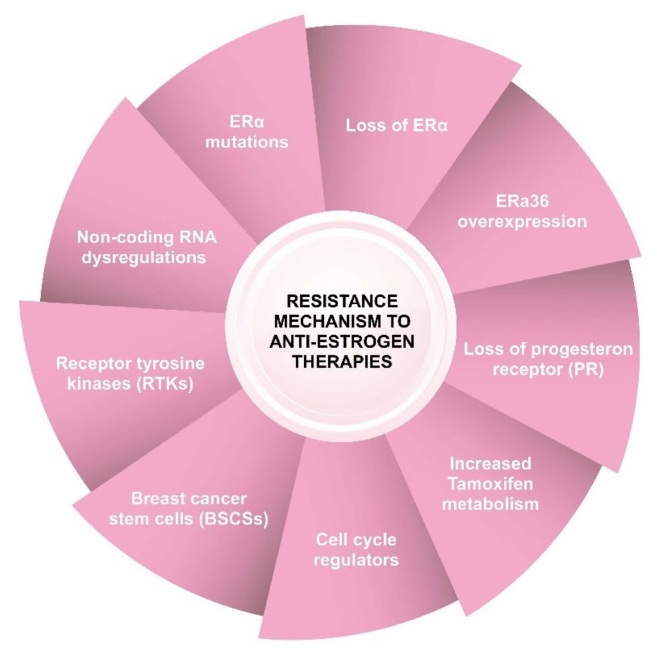
Figure 4. Resistance mechanisms to anti-estrogen